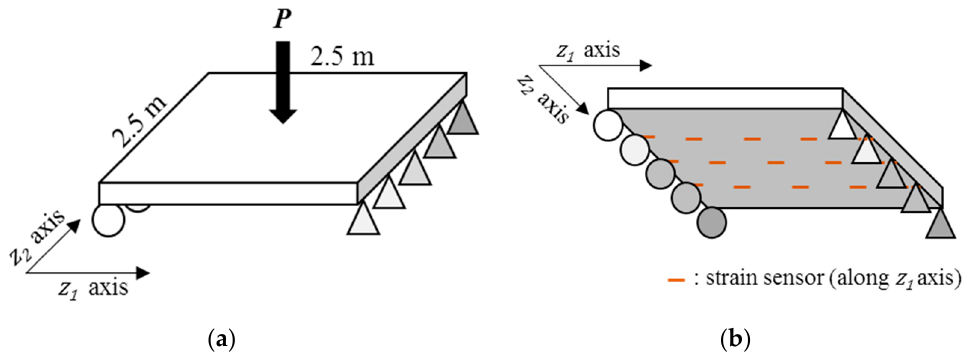
Figure 7. Static loading test setting: ( a ) Loading configurations; ( b ) Sensor configurations (strain).